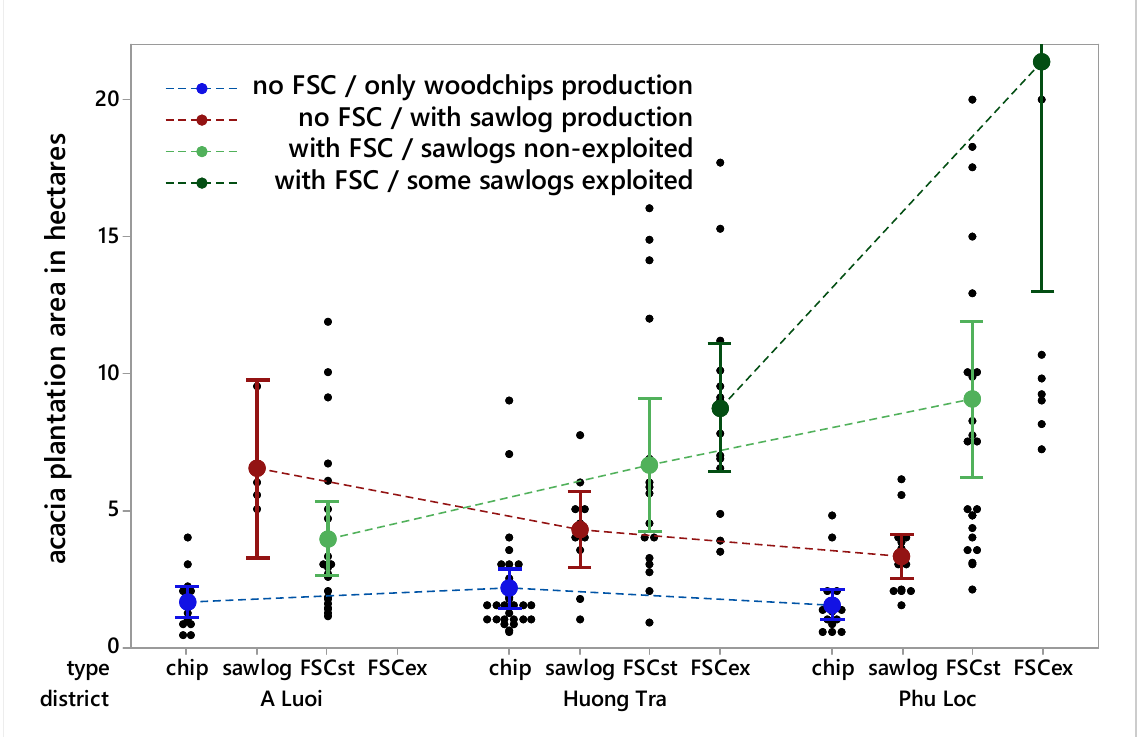
Figure 3. Interval plot showing the differences in acacia plantation areas (in hectares) cultivated by the 90 members of the FSC certification program (all producing sawlogs; 27 with FSC-sawlogs already exploited [FSCex] and 63 who just had started with FSC [FSCst]) and 90 non-members (28 producing sawlogs, and 62 producing woodchips only [chips]) among the three districts. The black dots show the individual data. The plantation areas of seven FSC-farmers at Phú L ộ c were larger than 18 hectares (i.e., beyond indicated Y-scale), with a maximum at 46 hectares. Note that some plantations of sawlog producers also served to produce woodchips. Spikes indicate the mean and 95% confidence interval. All data from farmer interviews.